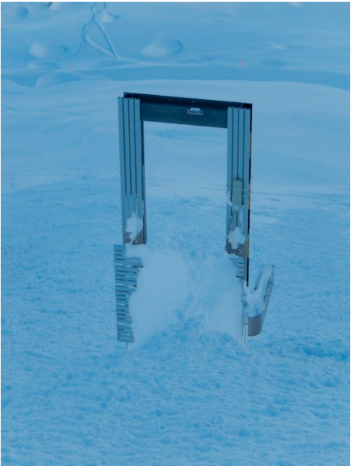
Figure 11. Deposition upstream the obstacle left from the avalanche on 20 January 2014. Photo E. Bovet.